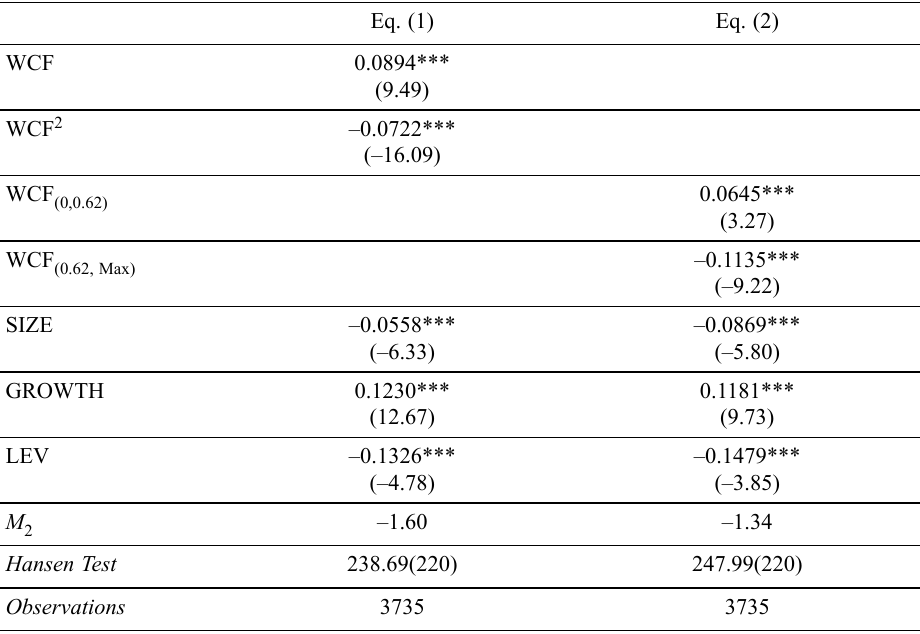
Table 3. Financing of working capital requirement and SME performance